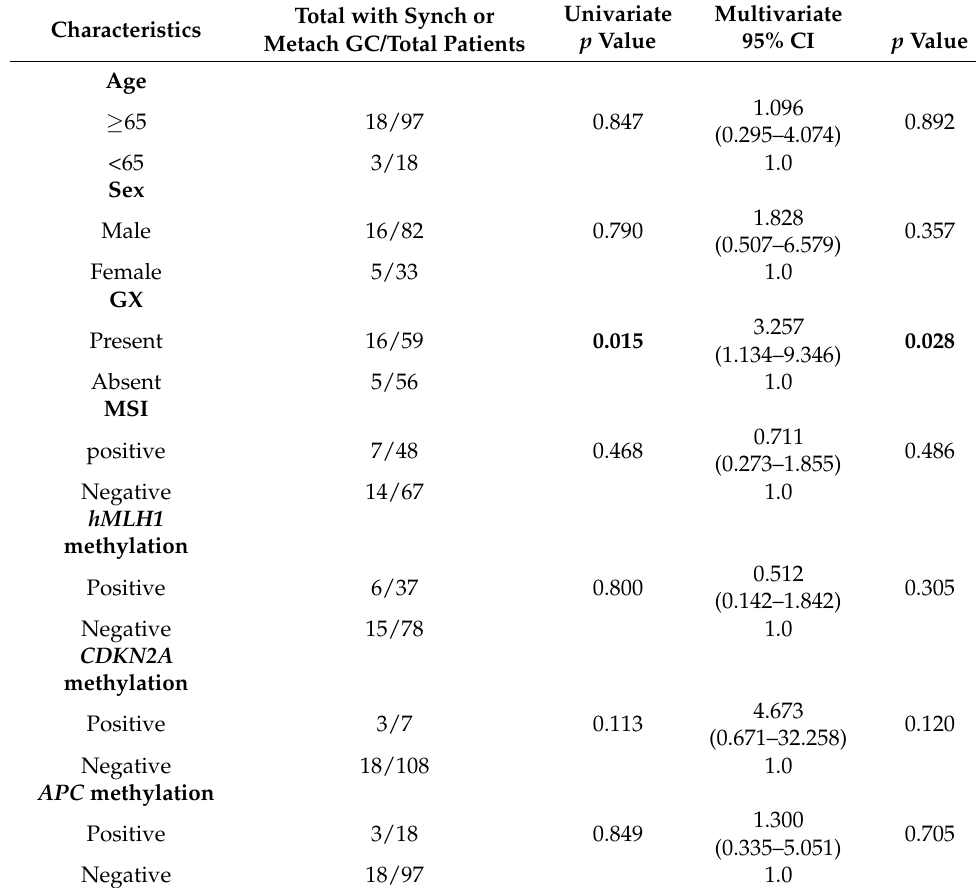
Table 4. Univariate and multivariate analyses of the cumulative incidence of synchronous or metachronous gastric cancer during endoscopic follow-up in patients after ESD